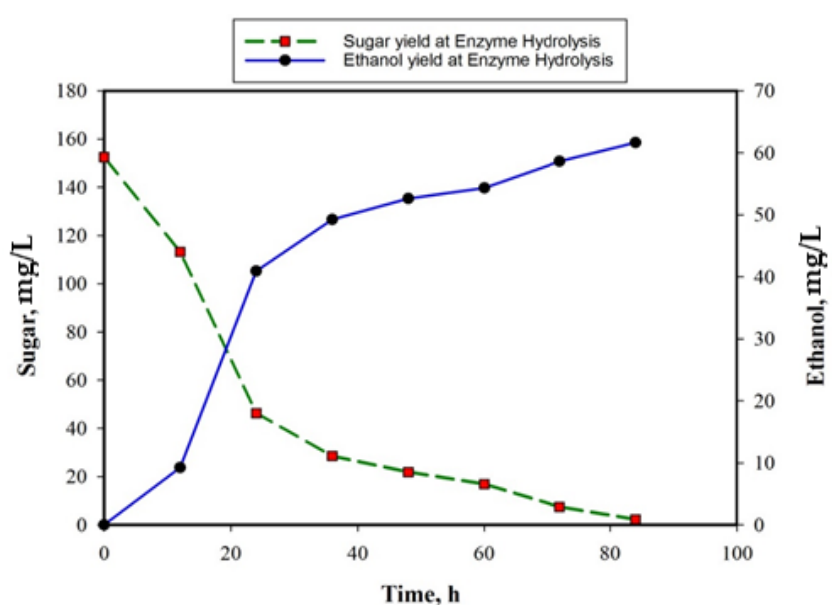
Figure 3. Ethanol yield and sugar yield residue of enzymatic hydrolyzed PEFBs at every 12 h of fermentation.